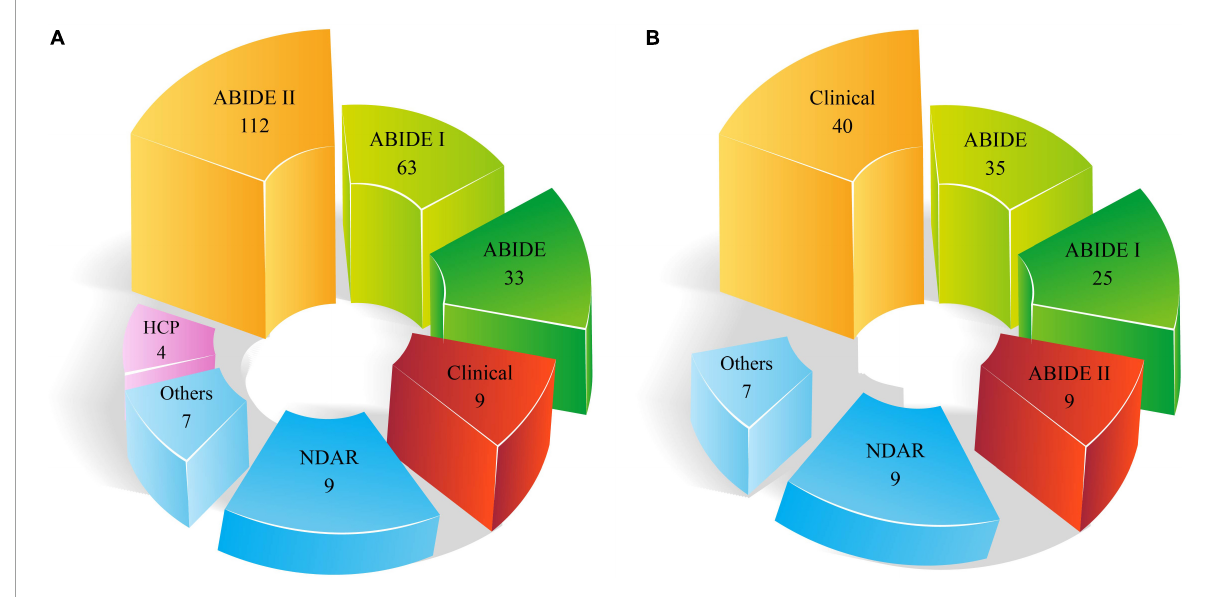
FIGURE5 Number of datasets used for automated ASD detection. (A) DL and (B) ML